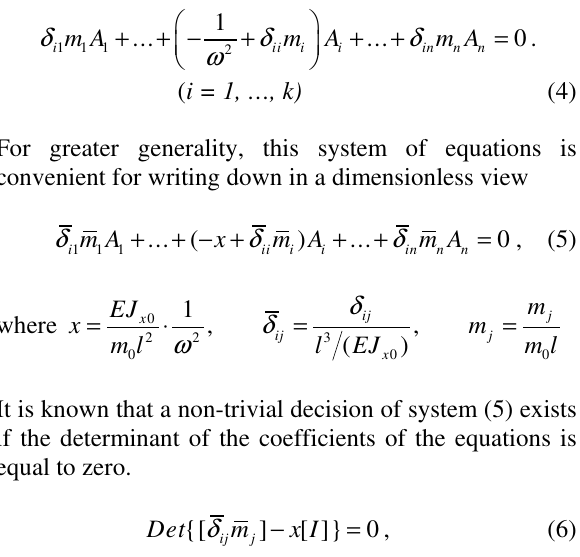
Fig 3. Distribution of the relative stiffness of the tail beam